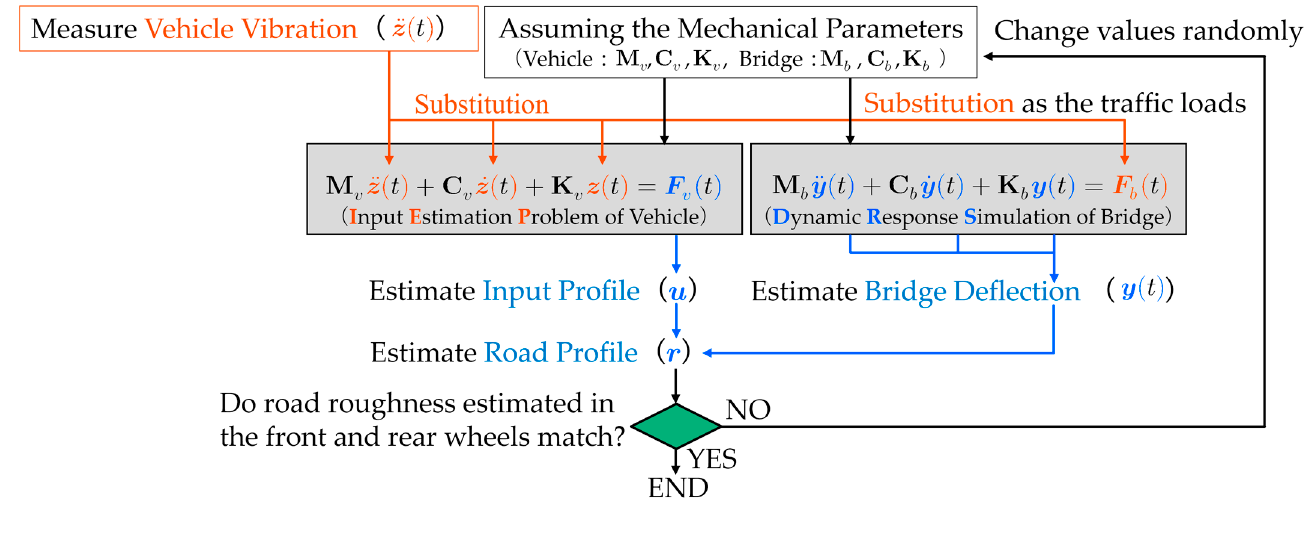
Figure 8. The algorithm of the PRE method.